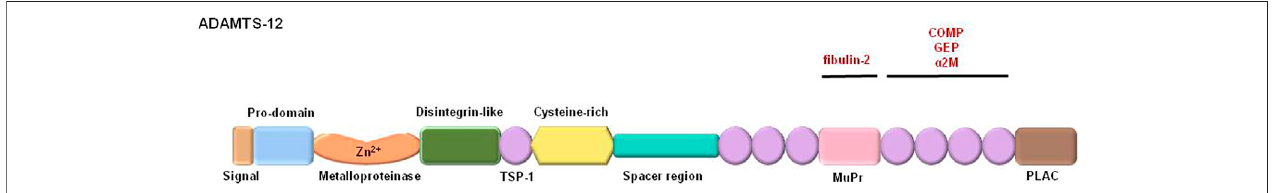
FIGURE 1 | Schematic representation of human ADAMTS-12. In black are shown the main domains of the protein; TSP-1: thrombospondin-like type-1 domain; MuPr: spacer two region. In red are shown proteins known to interact with ADAMTS-12; COMP: cartilage oligomeric matrix protein; GEP: granulin epithelial precursor; α